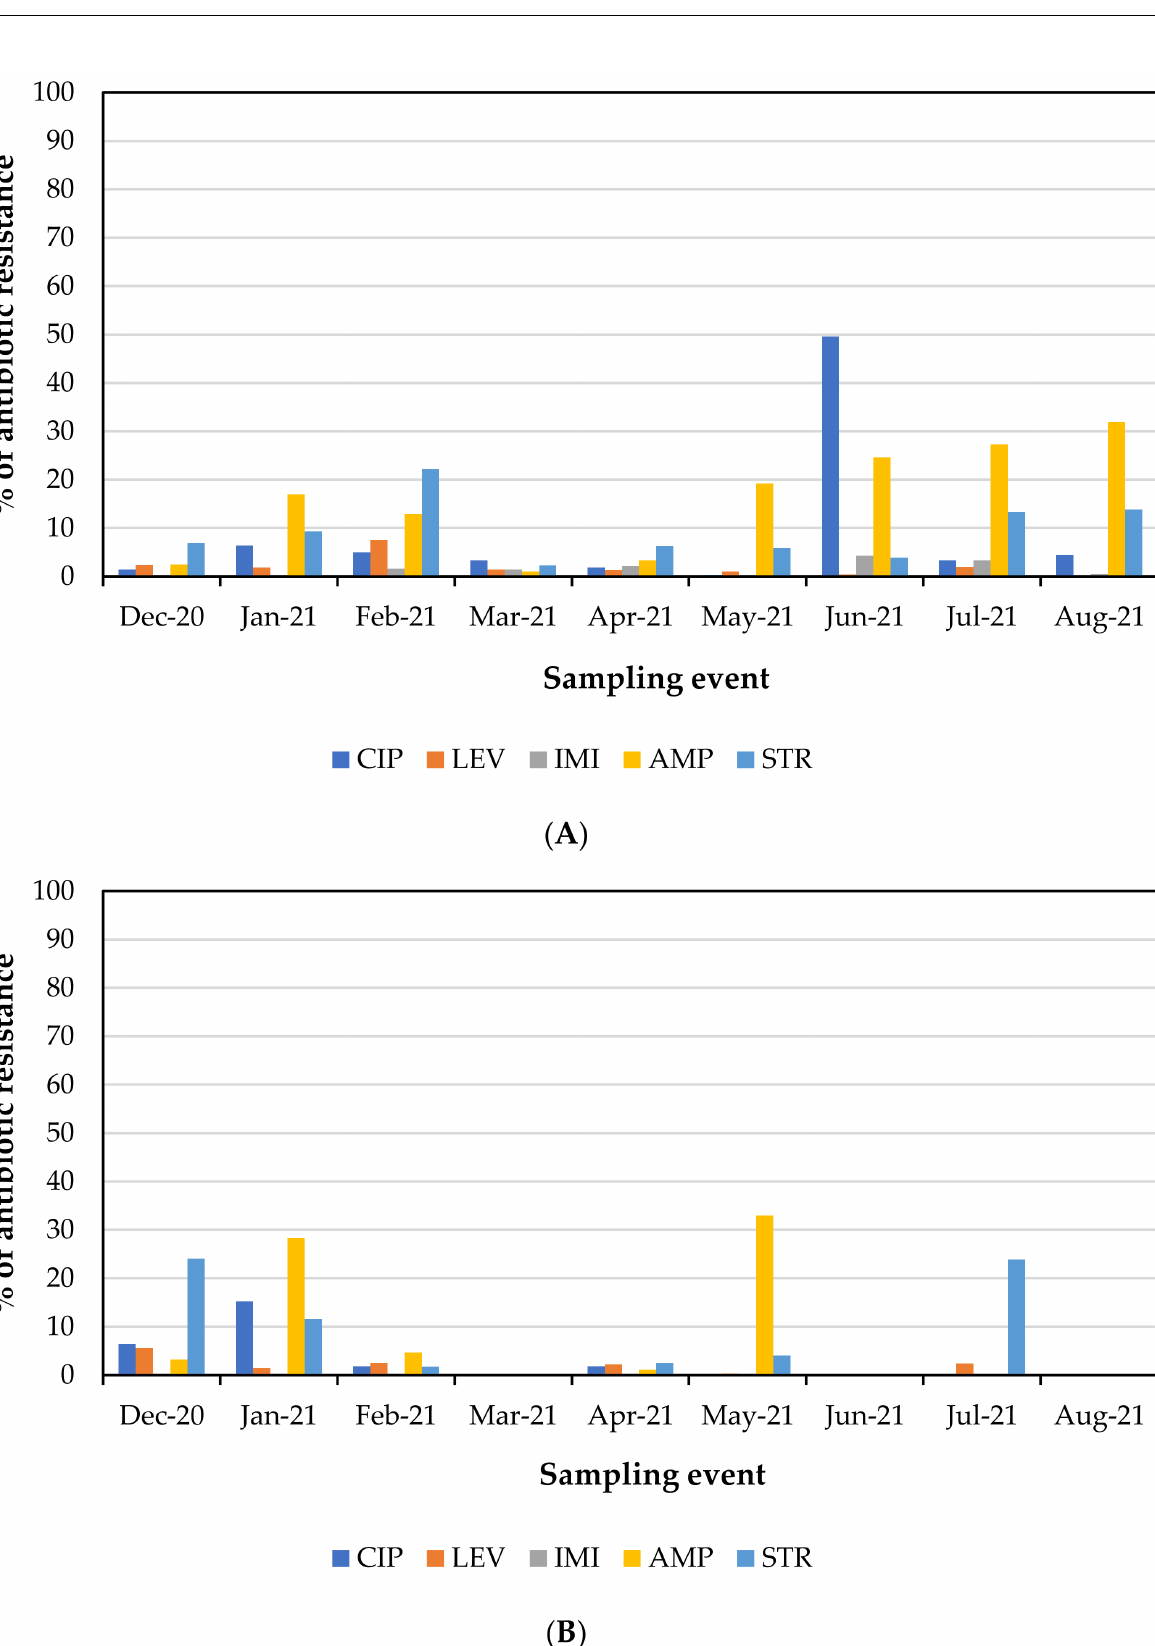
Figure 2. Percentage of total coliforms ( A ) and Escherichia coli ( B ) resistant to ciprofloxacin (CIP), lev- ofloxacin (LEV), imipenem (IMI), ampicillin (AMP), and streptomycin (STR) present in the collected surface water